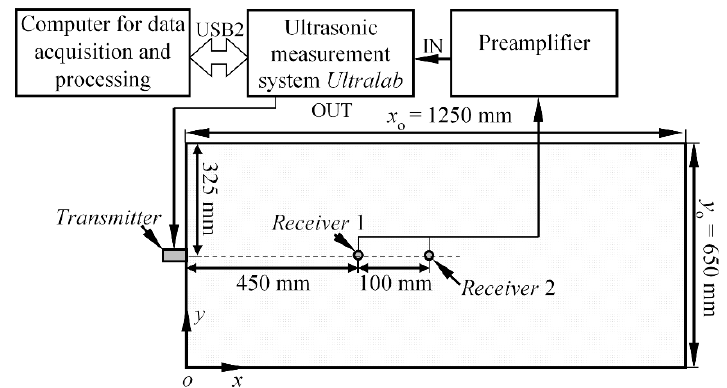
Figure 3. The schematic diagram of the experimental set-up for the validation of phase velocity estimation method.